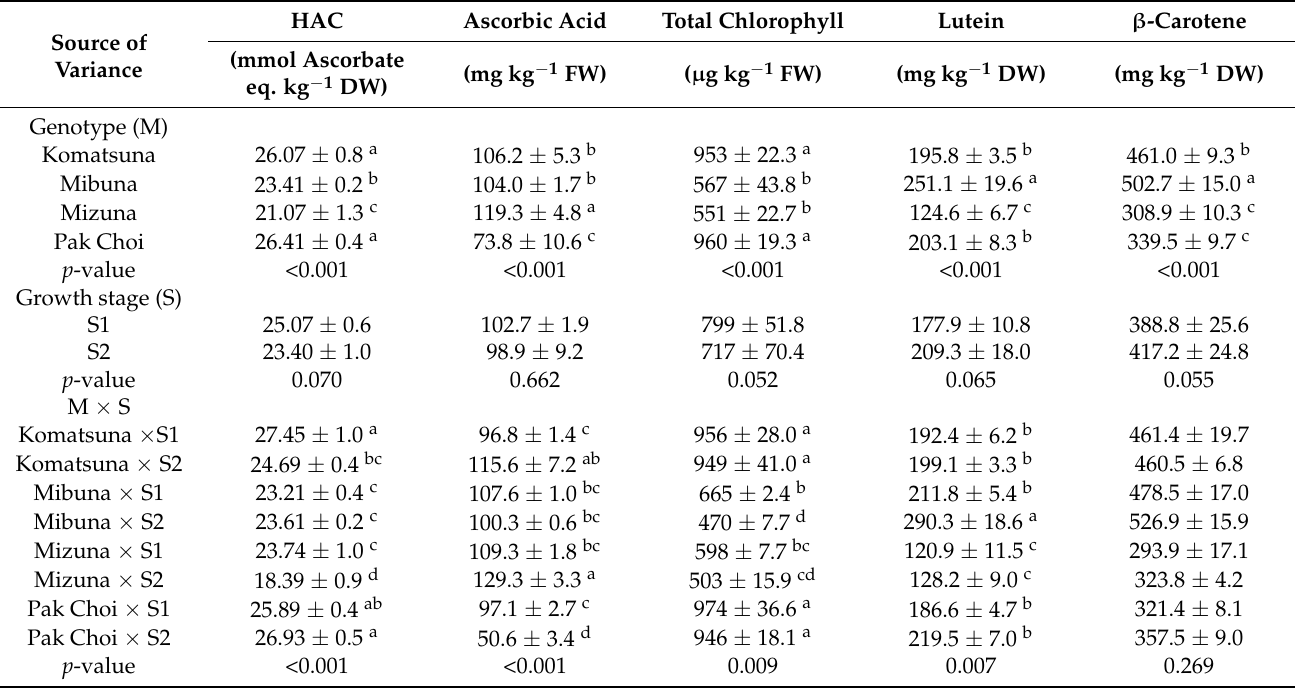
Table 3. Hydrophillic Antioxidant Capacity (HAC), ascorbic acid, total chlorophyll, lutein and β -carotene contents of four Brassica rapa L. microgreens harvested at the first (S1) or second true-leaf stage (S2). All data are expressed as mean ± standard error, n =